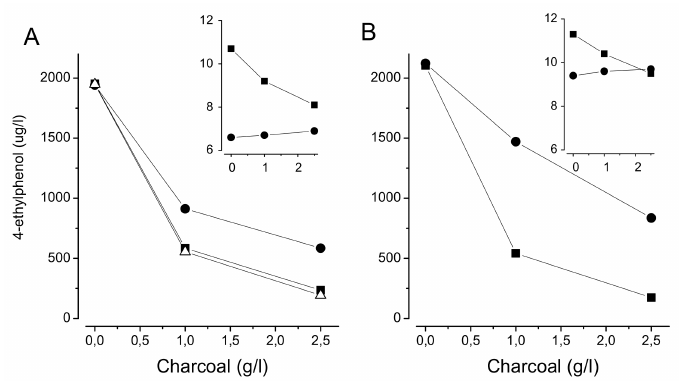
Figure 4. Effect of activated charcoal on the reduction of 4-EP ( µ g/L) in two red different wines ( A , B ) after 3 ( ), 10 ( (cid:4) ) and 21 days ( ∆ ) of contact. Insertions: effect on color intensity ( (cid:4) ) and hue ( × 10, ) after 10 days of